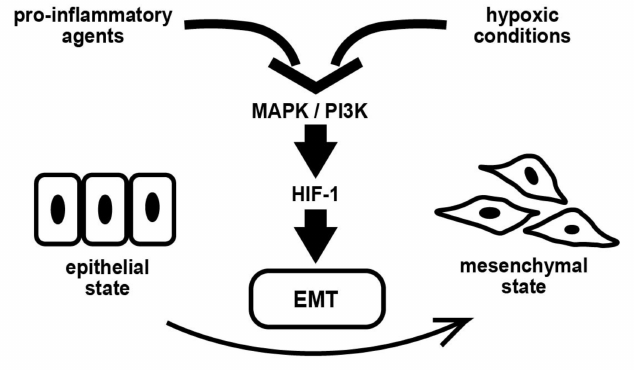
Figure 9. Overall scheme of the effects of pro-inflammatory agents in endometrial epithelial cells. Abbreviations: HIF-1—hypoxia-inducible factor-1; EMT—epithelial–mesenchymal